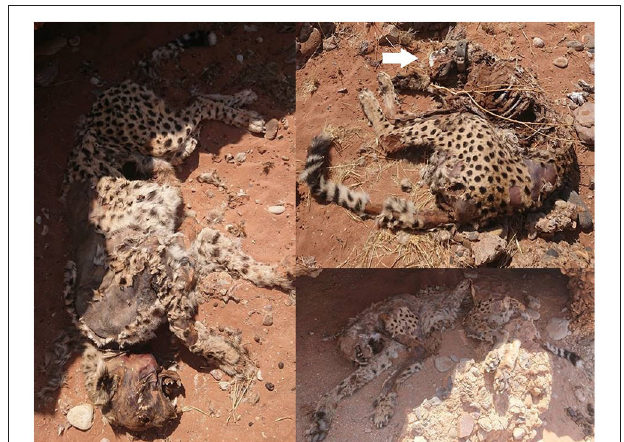
FIGURE 2 | Close up of the carcasses of the three cheetahs. These pictures were taken during the second visit, 22 days after the estimated time of death. Note the GPS collar on the neck of the upper right cheetah pointed out by a white